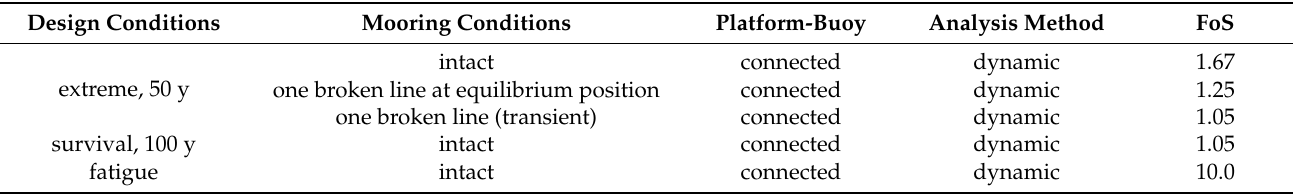
Table 2. Mooring line safety factors (WEC platform